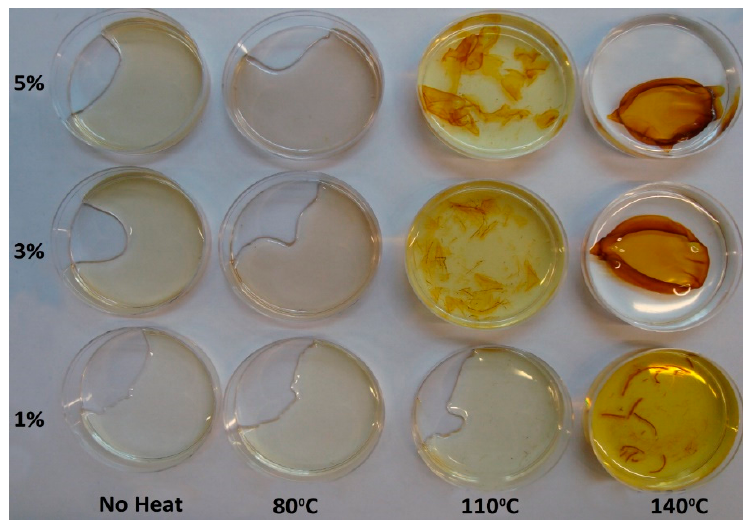
Figure 3. The same films as shown in Figure 2 after seven days’ incubation in water at 37 °C with constant agitation at 70 rpm.